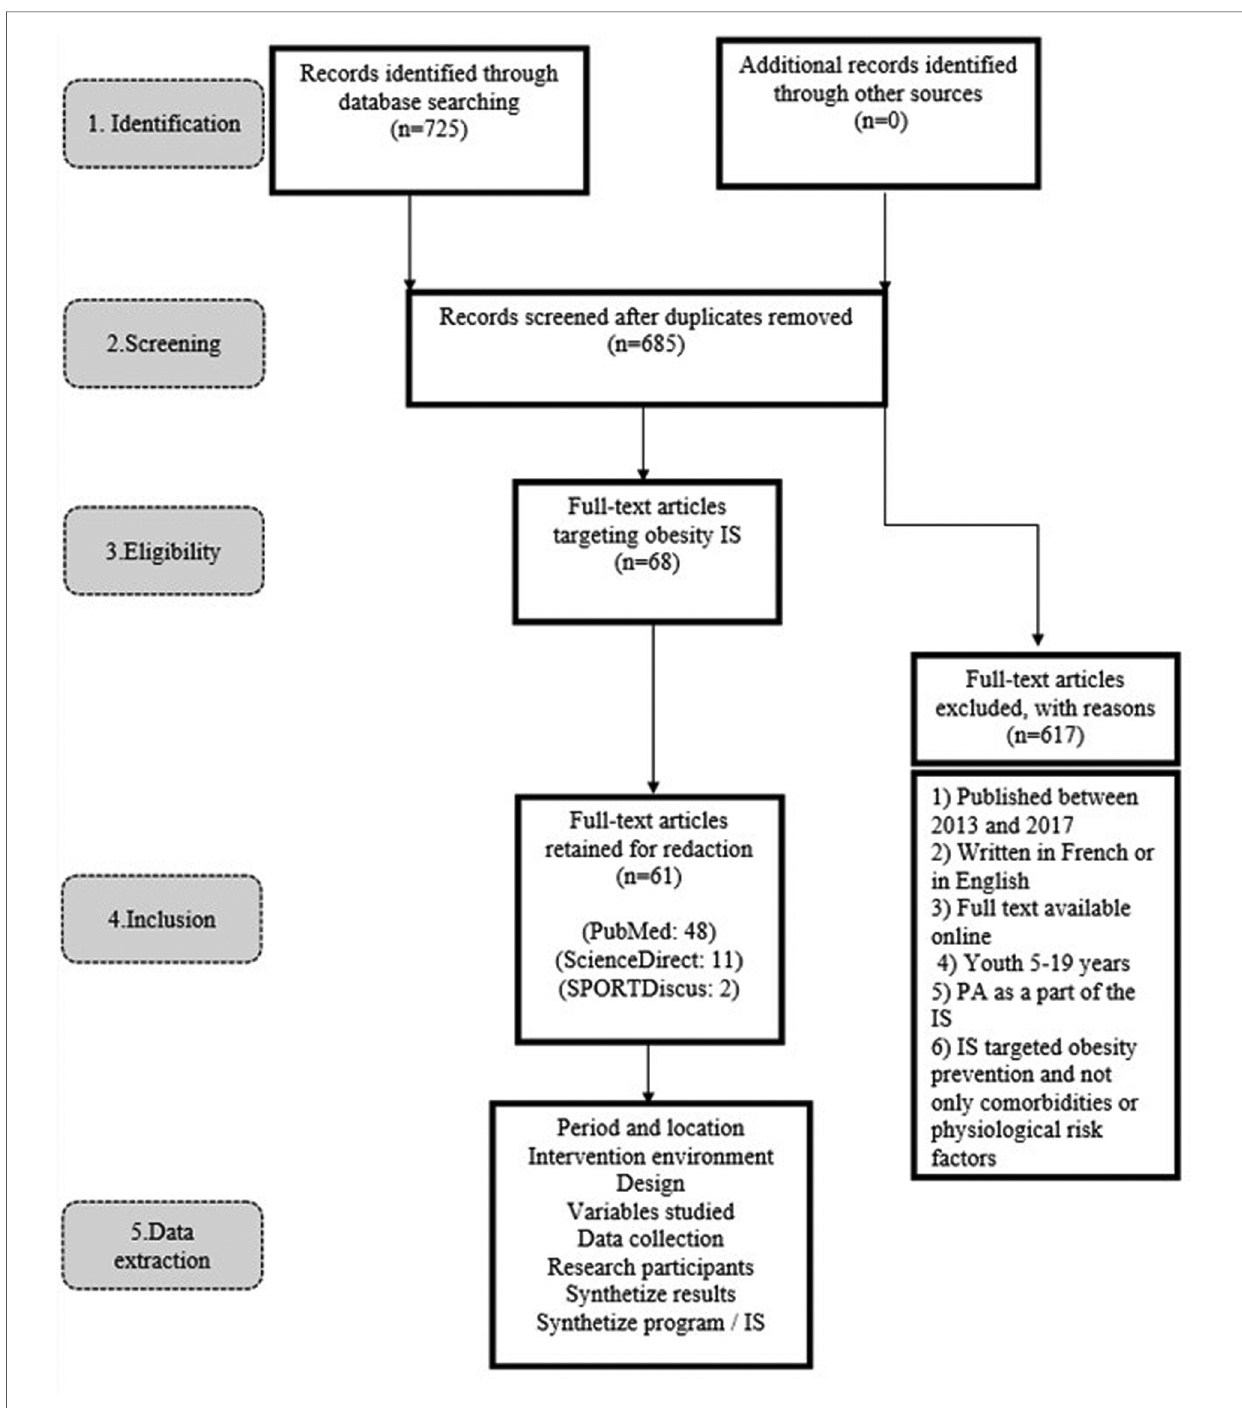
FIGURE 1 PRISMA fl ow